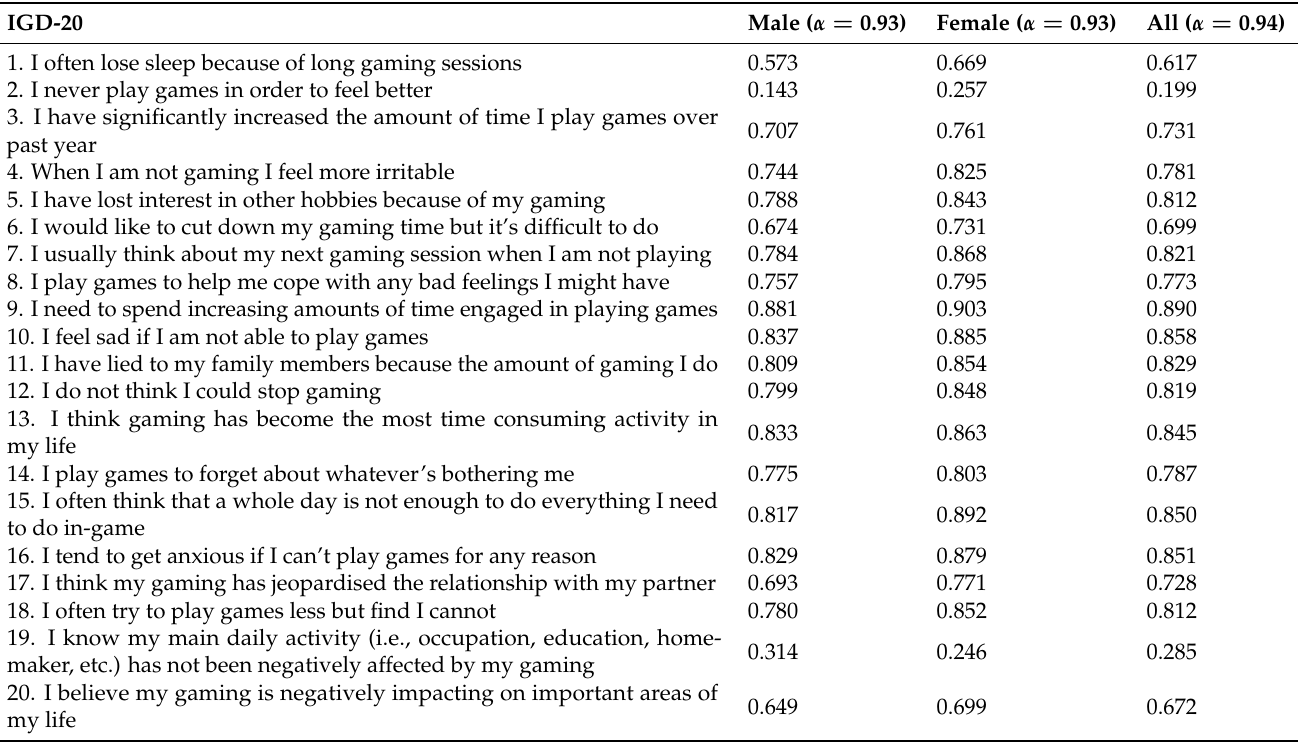
Table 3. Factor loadings of the IGD-20 test and Cronbach’s α .